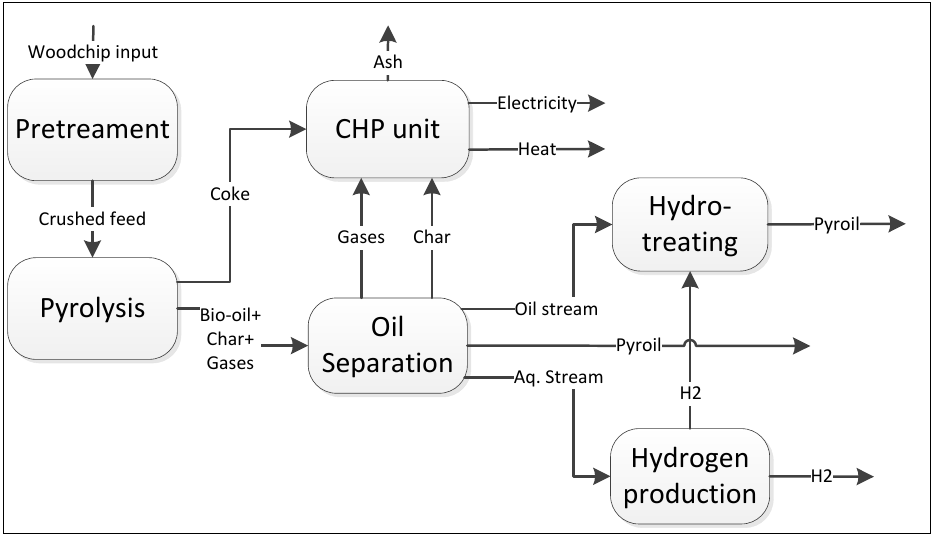
Figure 1. Process scheme for catalytic and thermal woodchip pyrolysis and upgrading of bio-oil.